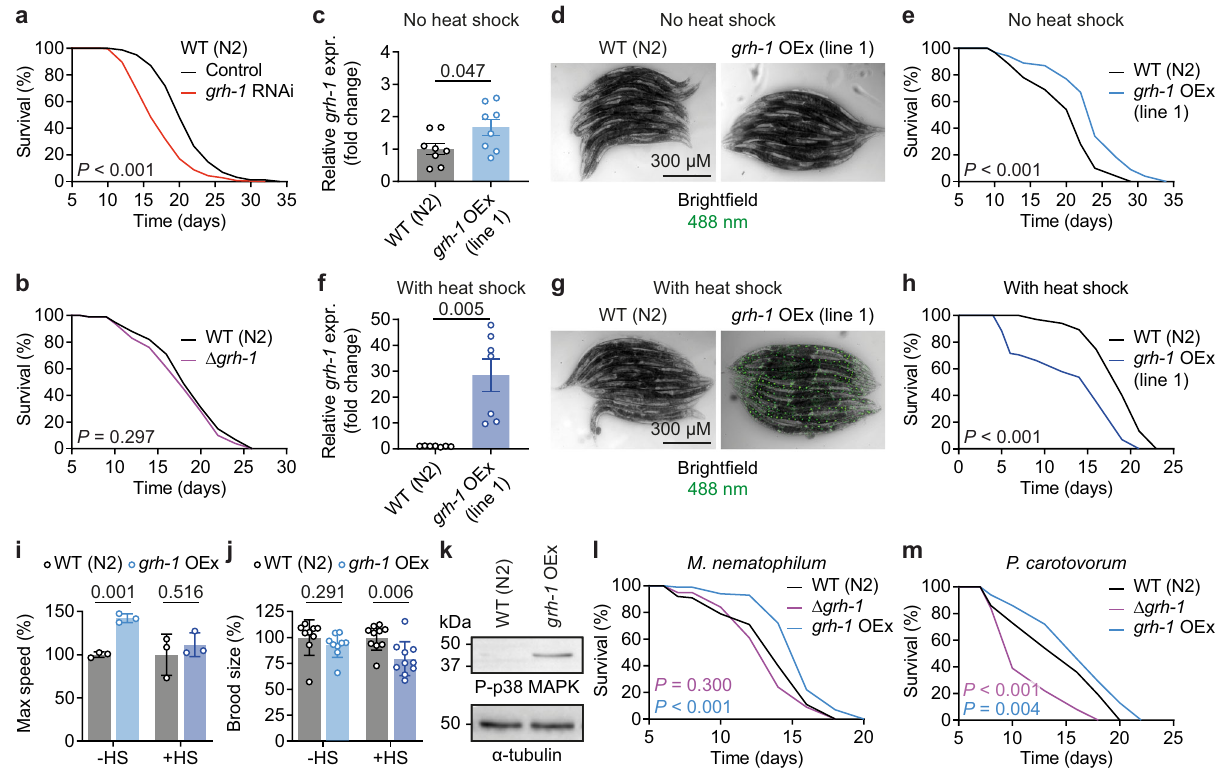
Fig. 1 GRH-1 is a longevity-promoting transcription factor. a Lifespan assay of wild-type (WT) N2 nematodes on post-developmental grh-1 RNAi compared to control vector L4440. b Lifespan assay on OP50 bacteria using a grh-1 deletion strain (null mutant VC2072) vs. WT (N2). c – e WT (N2) vs.